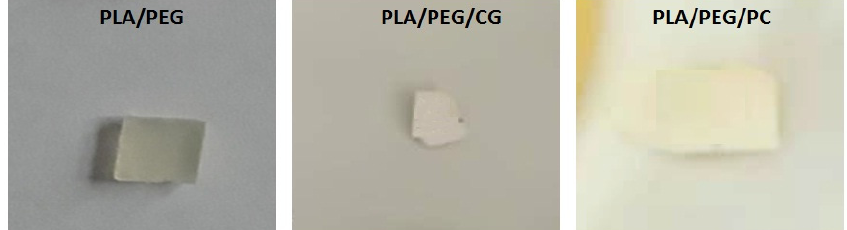
Figure 1. Visual appearance of PLA/polyethylene glycol (PEG) sample before and after 7 days